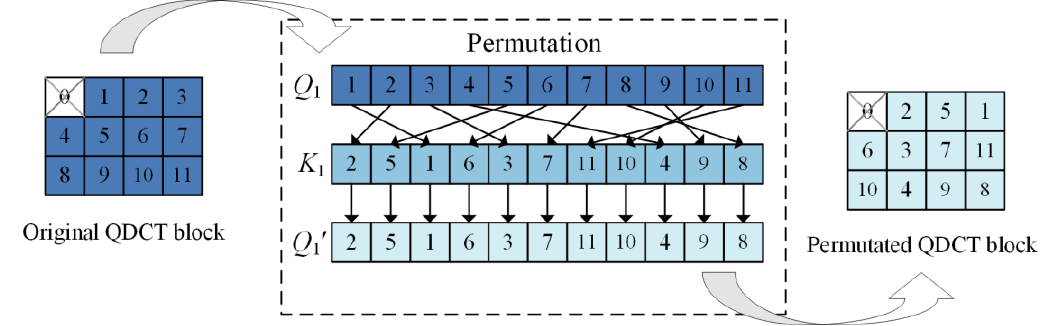
Figure 4. Permutation of QDCT block.